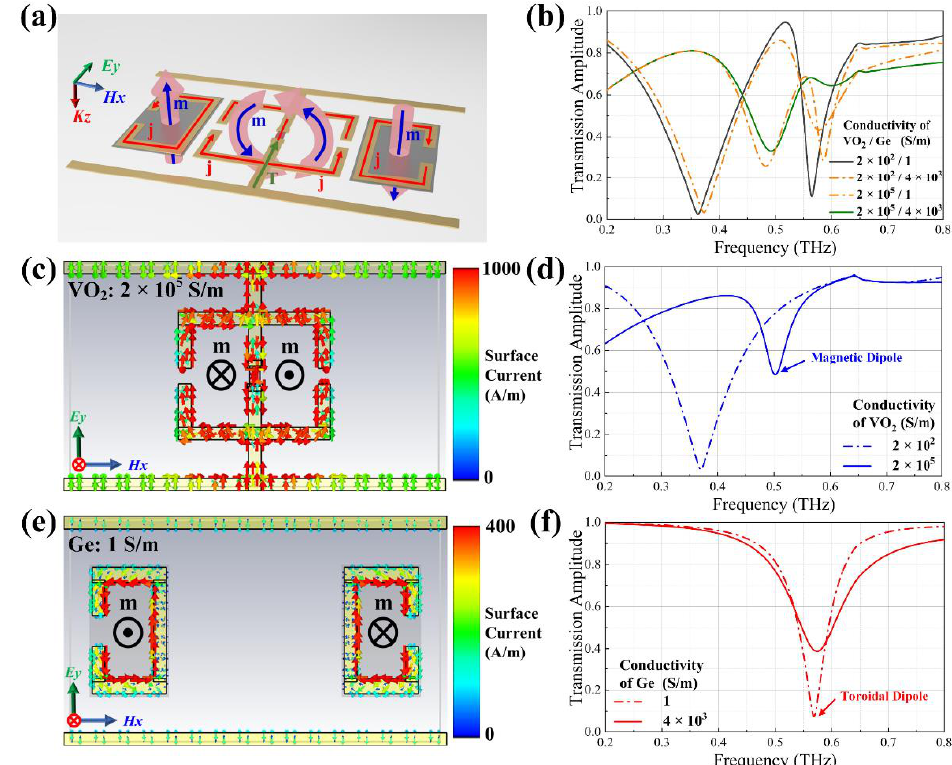
Figure 2. Resonance schematics and simulated transmission spectra of the designed unit. ( a ) Diagram of the transmit directions of the magnetic field and surface current. ( b ) Transmission spectra of the proposed metasurface for both materials with or without excitation. ( c ) Surface current distribution on SRR Ⅰ and SRR Ⅱ alone at the VO 2 conductivity of 2 × 10 5 S/m. ( d ) Transmission spectra of SRR Ⅰ and SRR Ⅱ alone for VO 2 with or without excitation. ( e ) Surface current distribution on SRR Ⅲ and SRR Ⅳ alone at the Ge conductivity of 4 × 10 3 S/m. ( f ) Transmission spectra of SRR Ⅲ and SRR Ⅳ alone for Ge with or without excitation.